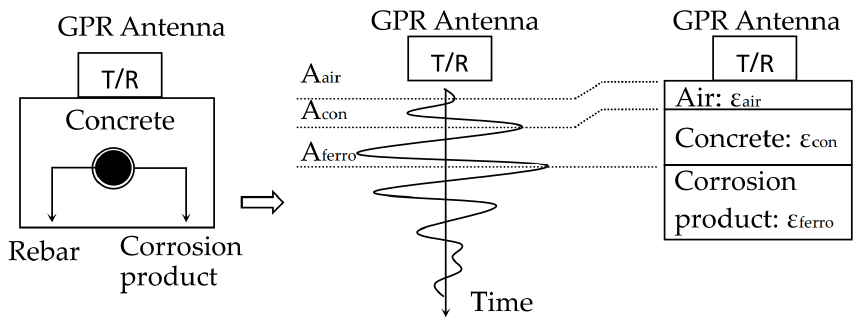
Figure 3. Electromagnetic Wave Reflection Signal in GPR.